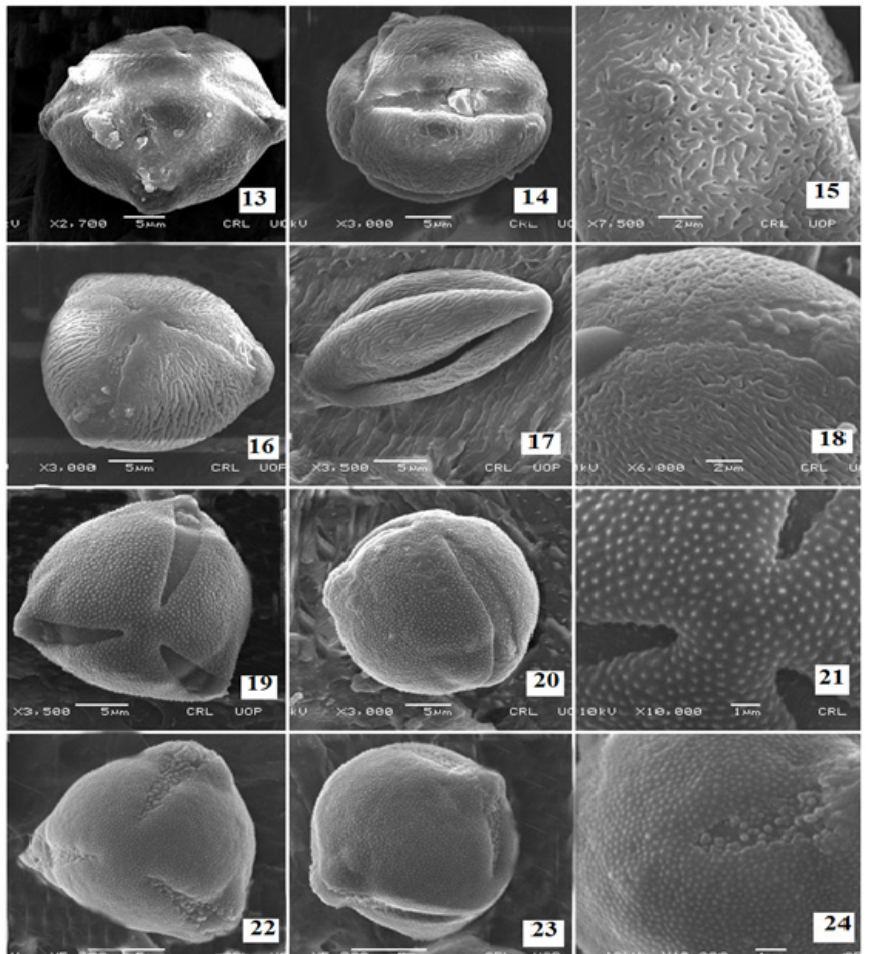
Figure 4. Scanning electron microscope photomicrographs of Solanaceous pollen grains. The scale bar represents 5 and